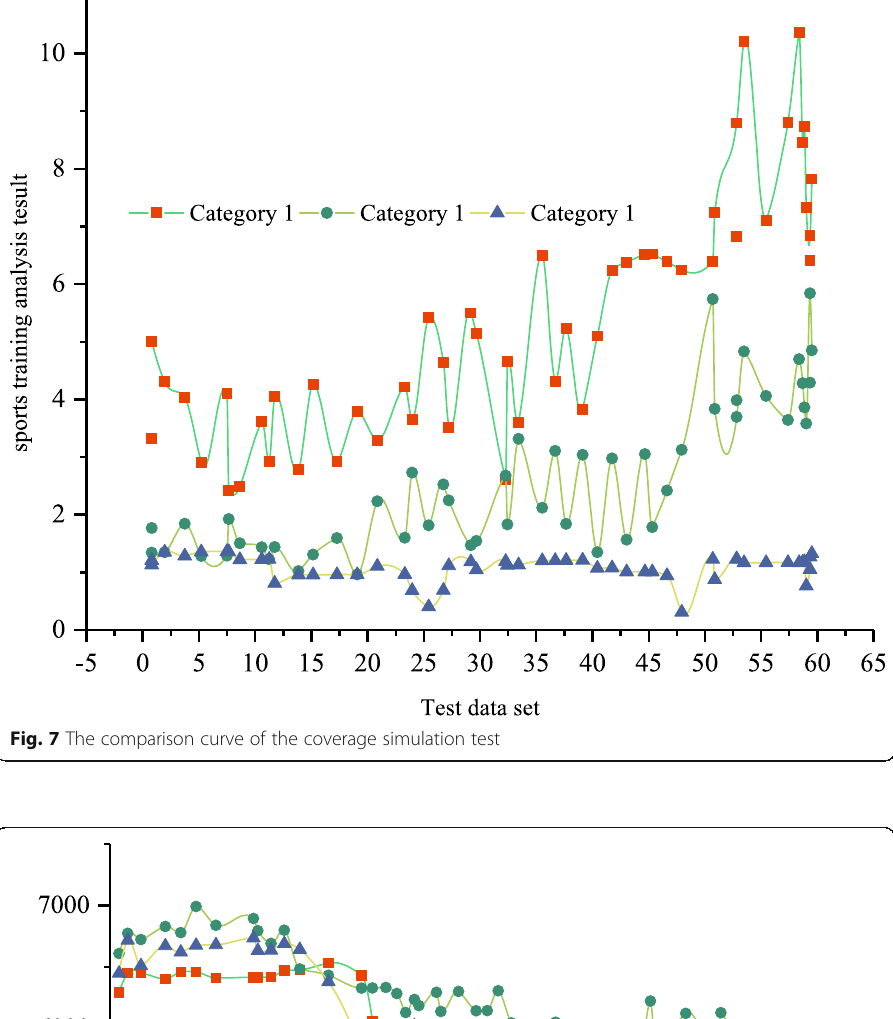
Fig. 7 The comparison curve of the coverage simulation test